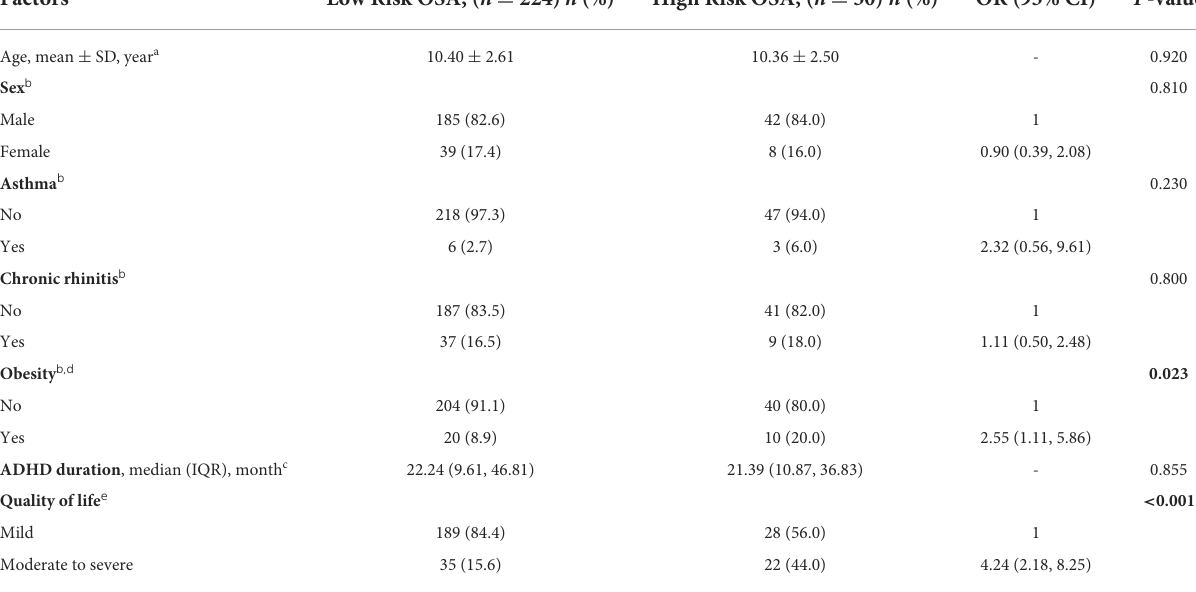
TABLE 4 Univariate analysis of associated factors for high-risk OSA in ADHD children ( n = 274). Factors Low Risk OSA, ( n = 224) n (%)